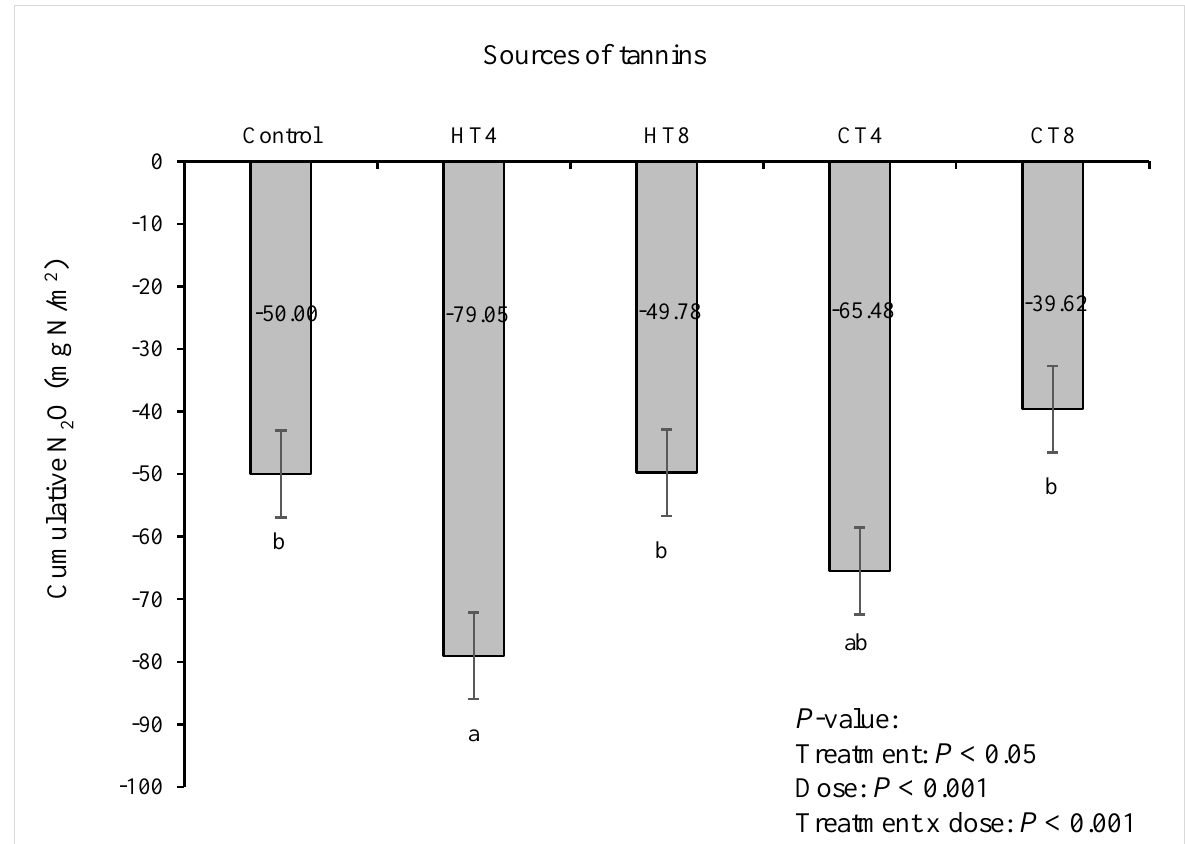
Figure 5. The effect of sources of tannins on cumulative nitrous oxide (N 2 O) emissions from in vitro incubation with dairy cattle manure for 14 d. Data show means ( n = 3), numbers in a row followed by different lowercase letters ( a,b ) indicate treatment effect ( p < 0.05). R 2 = 1.44. CT = quebracho condensed tannins (4% and 8%); HT = chestnut hydrolysable tannins (4% and 8%). Error bars represent the standard error of the means. N O fluxes ( Figure 4 ) varied significantly between two types of tannin sources. Intermediate N O reduction rates 2 2 were detected for HT between −0.2 and −0.4 mg/m 2 /h from d 0 to d 4. The addition of chestnut HT at 4% negatively impacted ( p < 0.001) cumulative N 2 O sinks (−79.05 mg/m 2 /h) when compared to the control (−50 mg/m 2 /h), 8% HT addition (−49.78 mg/m 2 /h) and/or 8% CT addition (−39.62 mg/m 2 /h) over the 14-d period ( Figure 5 ), indicating that HT may affect more N 2 O emission in dairy cattle manure compared to CT [92] . The HT treatments failed to affect CH 4 reduction. However, both CT and HT reduced ( p < 0.001) cumulative and flux rates of N 2 O emissions. The literature has reported that the maximum net negative N 2 O fluxes vary widely, from −0.14 to −0.48 mg/m 2 /h [93] . This indicates that dairy cattle manures are usually considered sources of net N2O emissions, but they can also act as sinks, similar to soils [93] . The sink strength depends on the potential for N 2 O reduction to N 2 , the ease of N 2 O diffusion within the soil profiles, and its dissolution in soil water [93] . In the presence of CT and HT, CH 4 and N 2 O production and the interrelationships of those GHG productions might be connected to specific changes in predominant microflora associated with supplementing tannins in the fermentation chamber ( Figure 6 ; [37,94] ). Therefore, both CT and HT could regulate N 2 O emissions associated with nitrification and denitrification by inhibiting decomposition and microbial activity [21,95] .